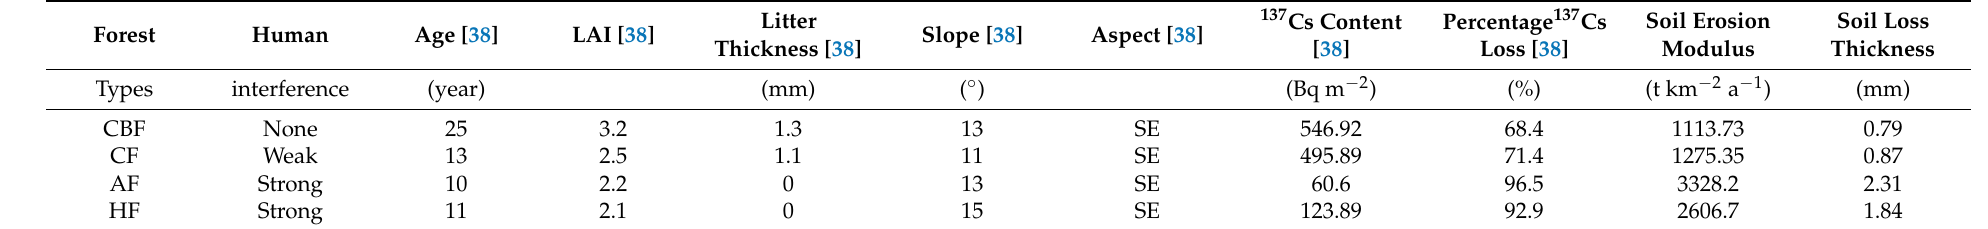
Table 1. Basic information of the study